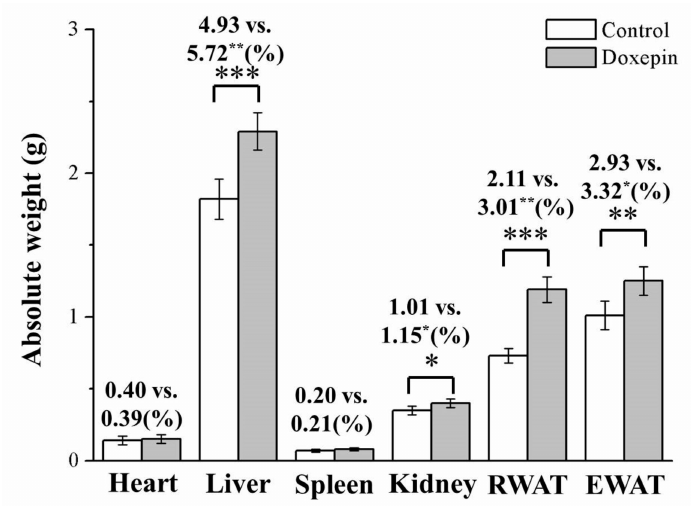
Figure 2. Absolute weights (i.e., percentages of the TBW) of the heart, spleen, liver, kidney, EWAT, and RWAT in control and doxepin-treated obese mice over 56 treatment days. All values represent means ± standard deviations ( n = 10 for all groups). * p < 0.05, ** p < 0.01, and *** p < 0.001 indicate statistical significance, high statistical significance, and very high statistical significance,